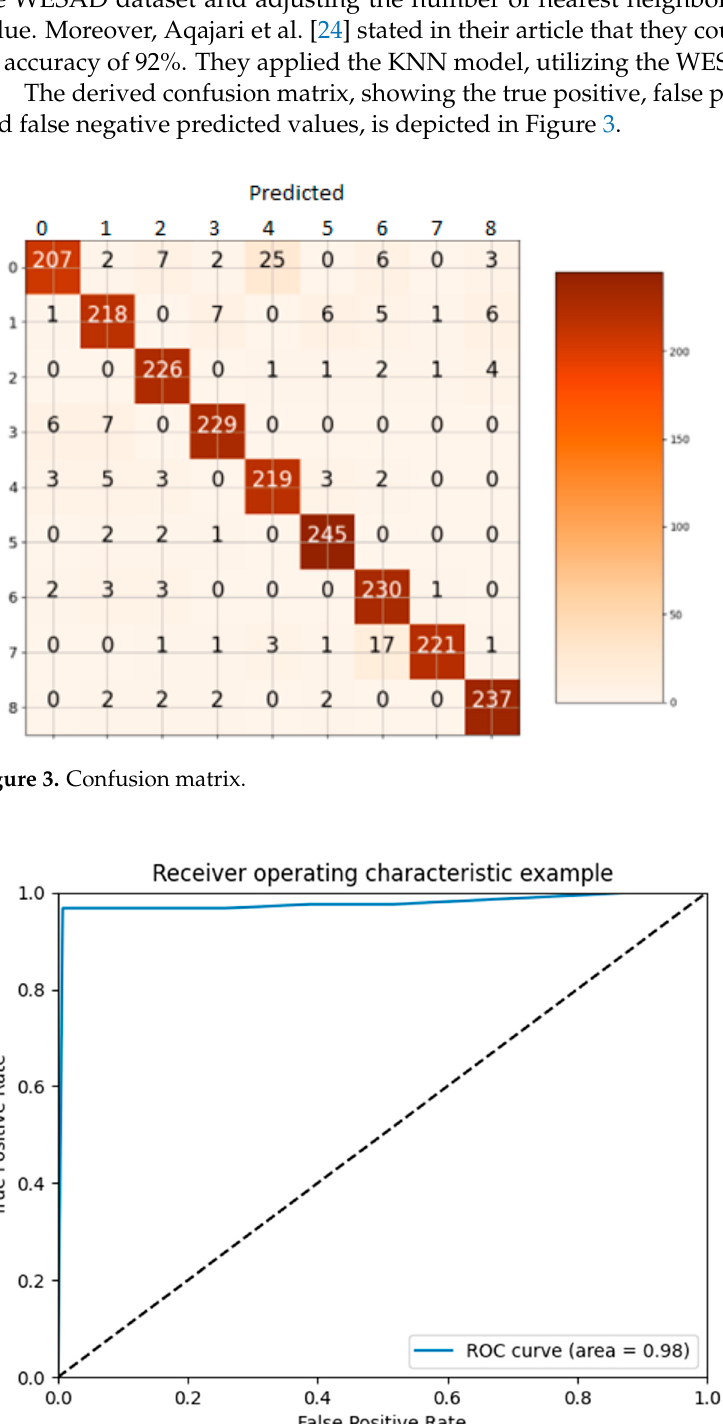
Figure 4. ROC curve (area under the ROC curve: 0.976666).